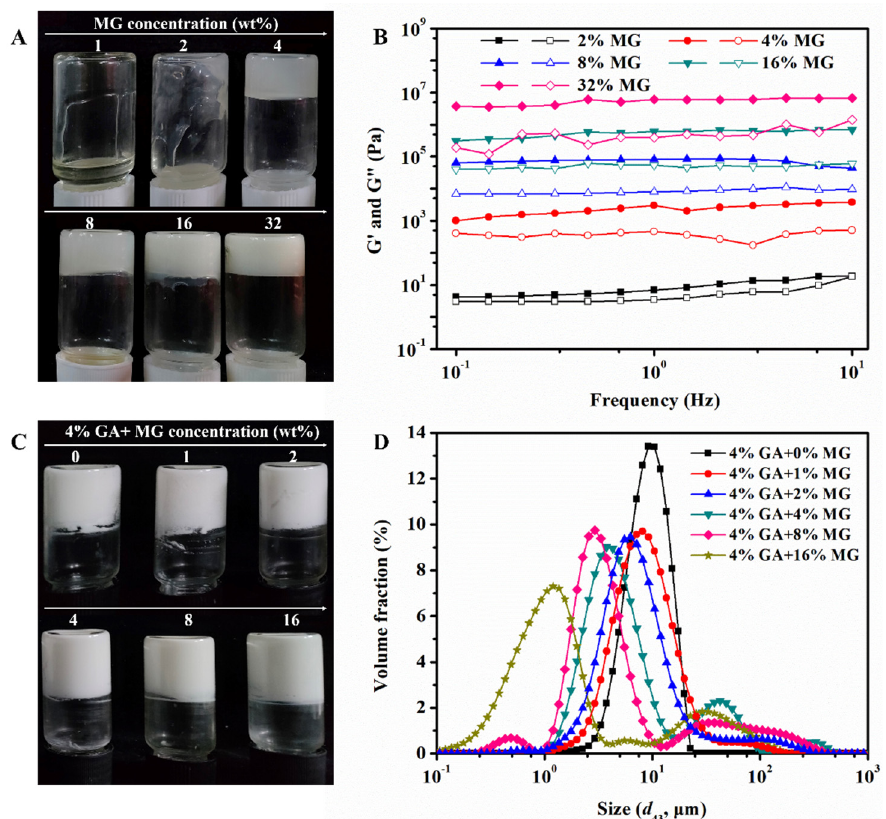
Figure 1. Photographs ( A ) and frequency sweeps ( B ) of MG oleogels with different MG concentrations (1–32 wt%). G ′ and G ″ are shown as filled and open symbols, respectively. Photographs ( C ) and droplet size distributions ( D ) of dual ‐ structured gel emulsions containing 50 wt% sunflower oil prepared at a constant GA nanofibril concentration (4 wt%) and different concentrations of MG (0–16 wt%).